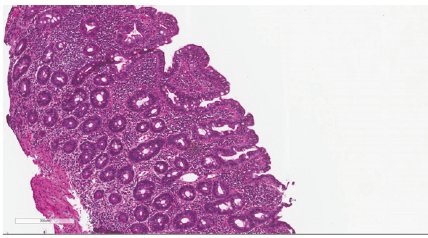
Figure 2: Duodenal biopsy demonstrating partial villous atrophy with crypt hyperplasia.